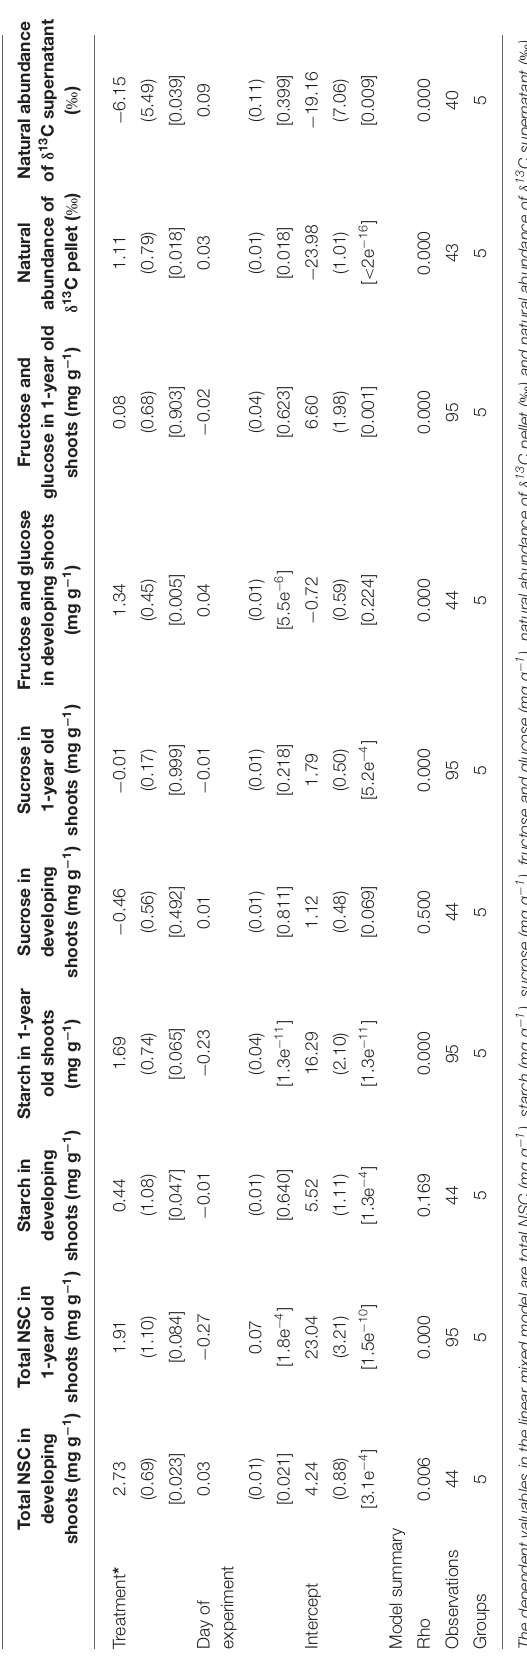
Figure 3A ). End of dormancy, bud break or photosynthetic resumption generally entailed a reduction in starch and sucrose, a pattern not observed for fructose and glucose ( Figures 3B,D,E